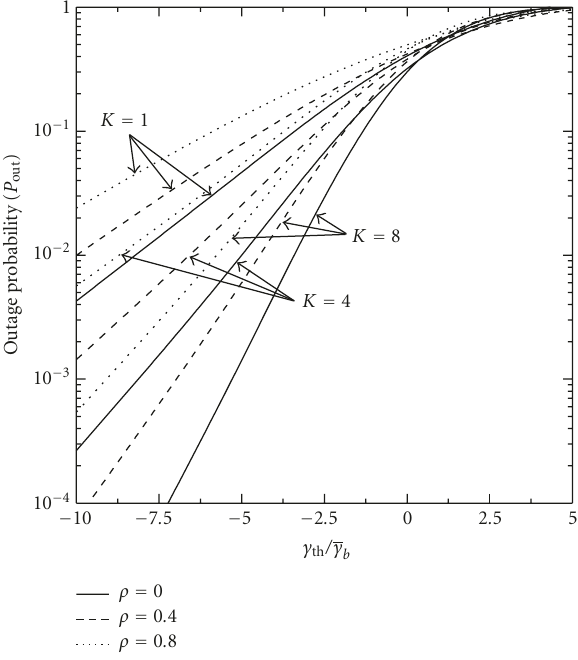
Figure 5: Outage probability ( P out ) versus the normalized average input SNR per bit for several values of the Ricean K -factor and the correlation coe ffi cient ρ .